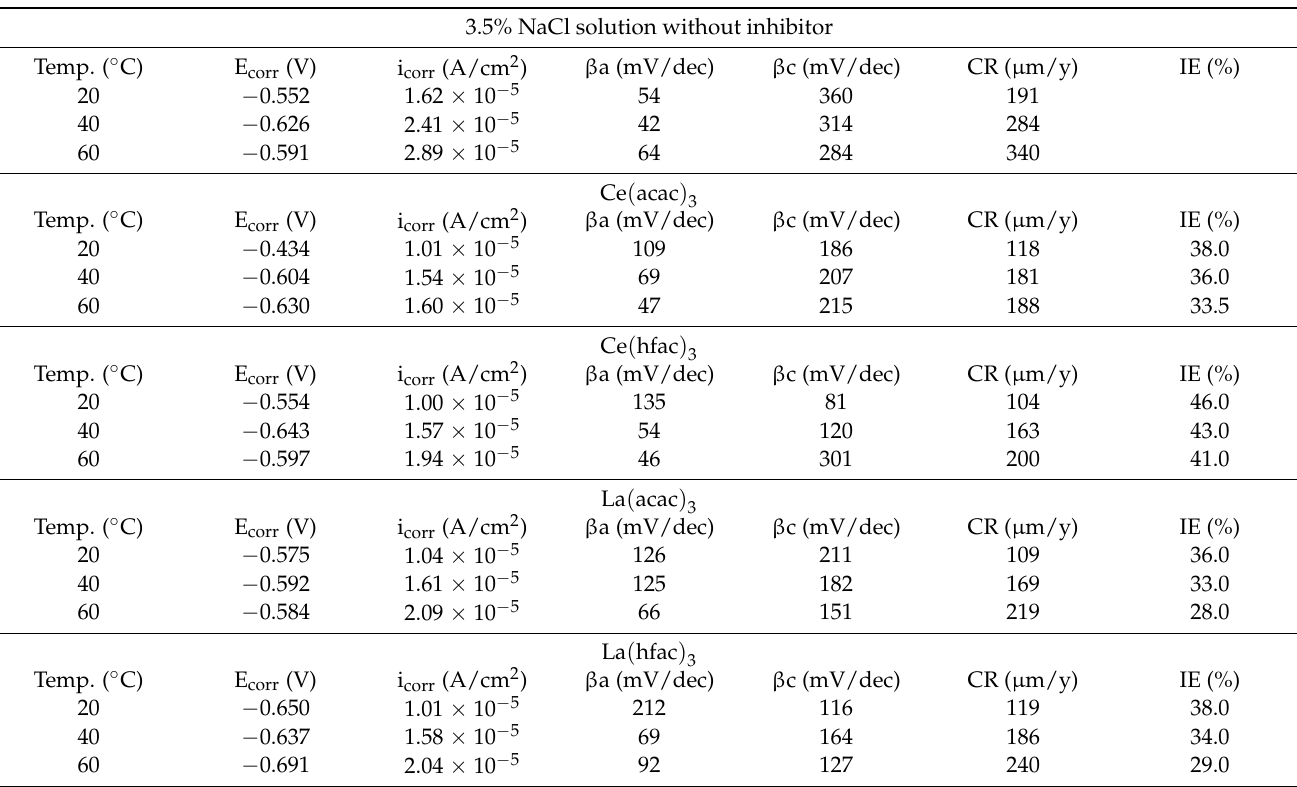
Table 3. Electrochemical parametersof MS obtained from the potentiodynamic polarisation curves. 3.5% NaCl solution without